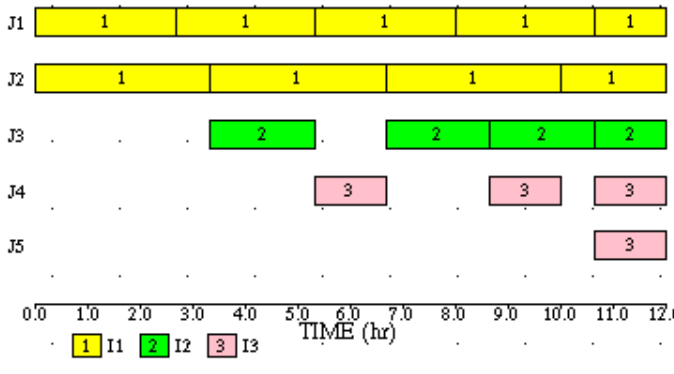
Figure 9. Example 3 Gantt chart.